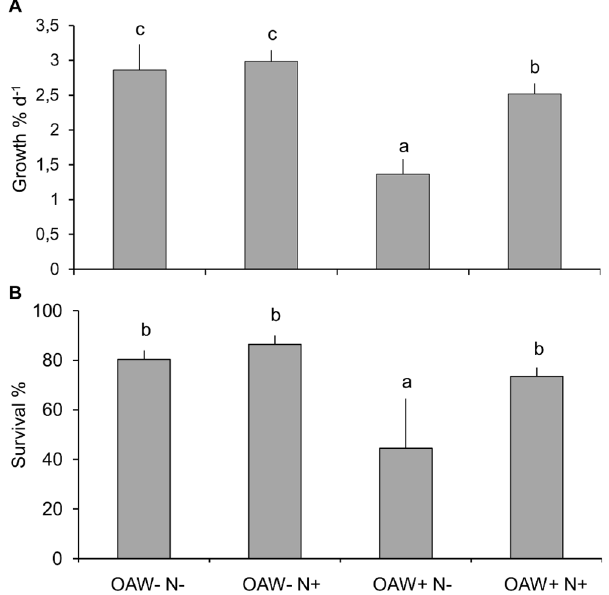
Fig 2. Growth and survival of F . vesiculosus germlings during the OAW x nutrient experiment. (A) Growth (% d -1 ) and (B) survival (%) (mean +SD, n = 3, 8 – 9 weeks) during summer 2014 at the four treatment levels OAW-N-, OAW-N+, OAW+N-, OAW+N+. Means were calculated from 16 sibling groups for each treatment ‘ OAW ’ and ‘ Nutrient ’ treatment combination. Different letters above the bars indicate significant differences (p-value < 0.05) between the treatments after Tukey ’ s